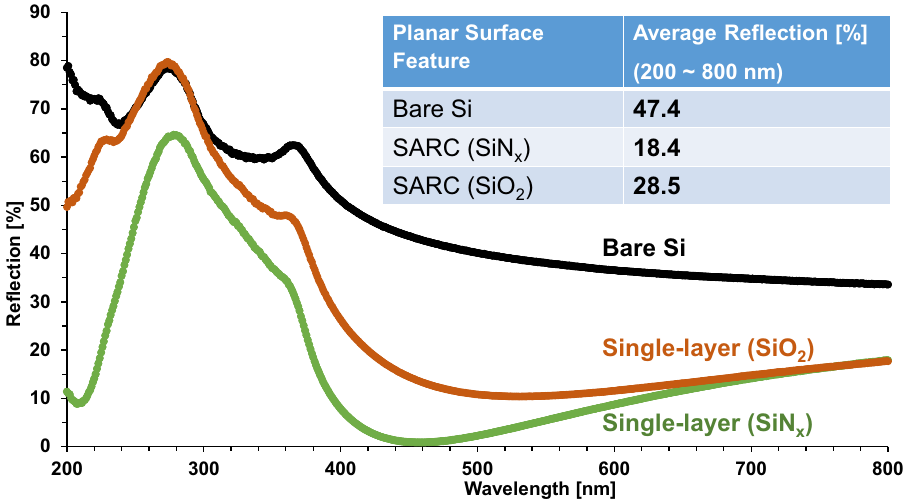
Figure 3. Reflection comparison of SiN x and SiO 2 as single-layer ARC on planar silicon surface. The insert table lists the average reflection from the measurement